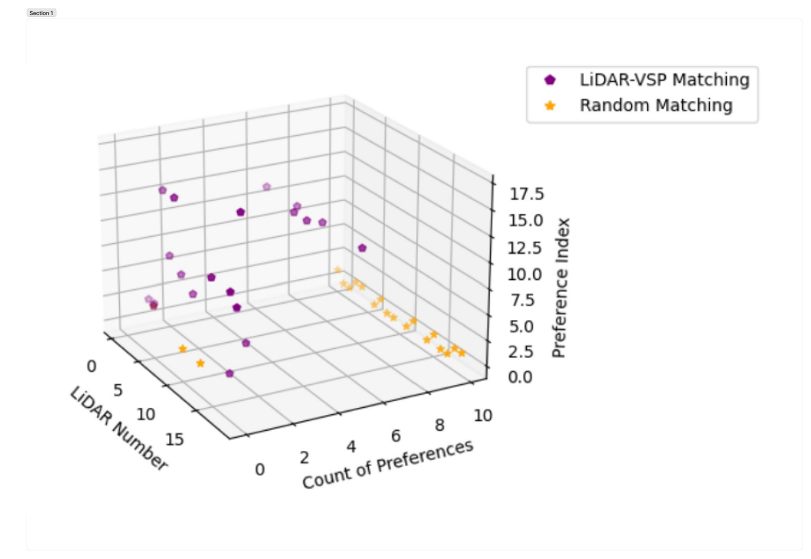
Figure 7. A three-dimensional plot between LiDARs, and preference index of allocated VSP while also factoring in and showing the frequency with which a particular preference index is chosen.